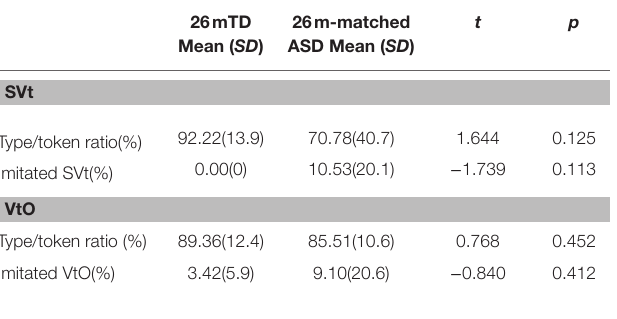
TABLE 5 | SVt and VtO used by 26 m TD children and 26 m-matched children with autism spectrum disorder (ASD).